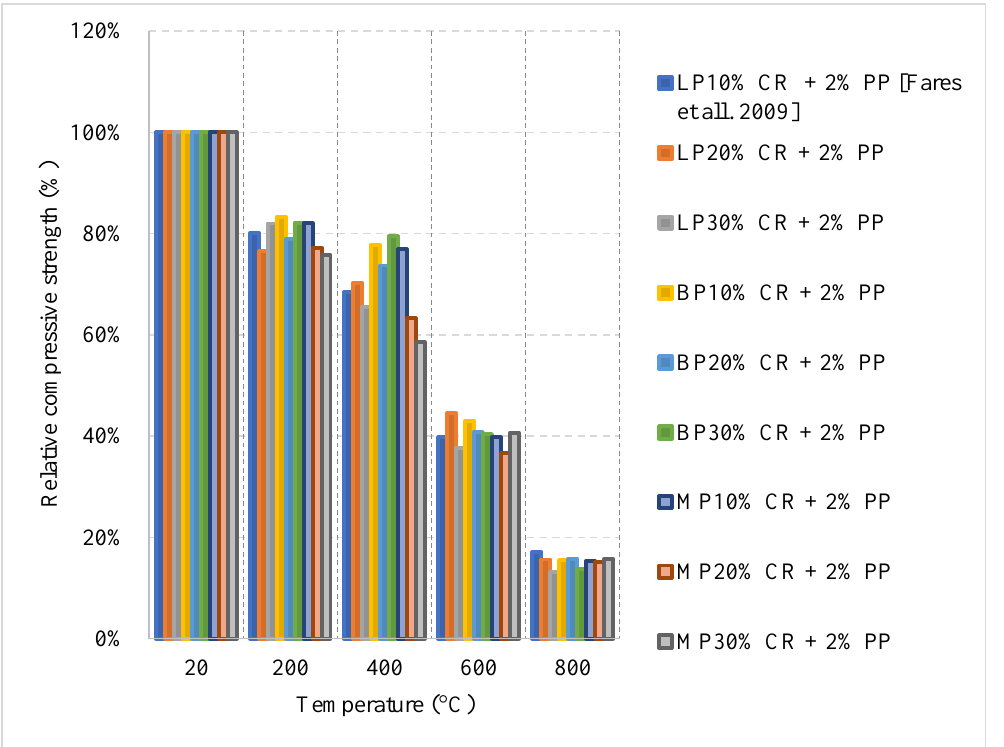
Figure 36. Relative compressive strength of Furnace cooled FRSCC with different constituents. LP: Limestone Powder, BP: Basalt Powder, MP: Marble Powder, PP: Polypropylene Fibers, CR: Cement Replacement [105].